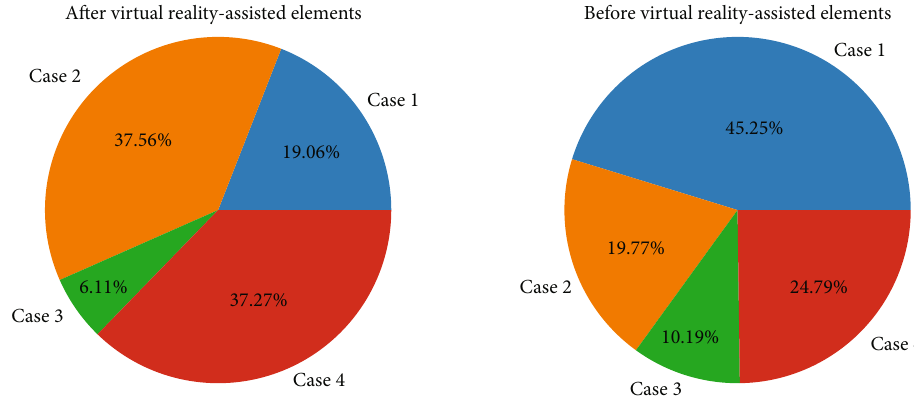
Figure 2: Virtual reality-assisted interactive music element data